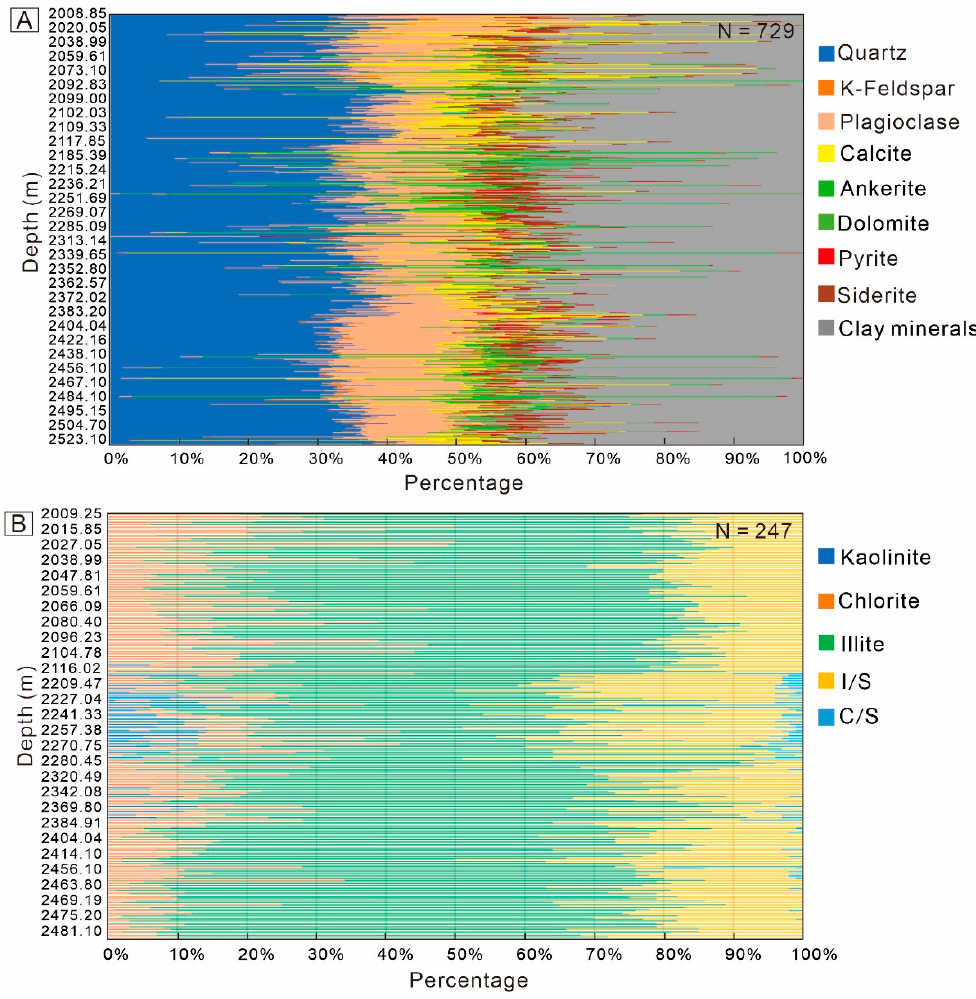
Figure 4. XRD data showing the mineral composition of the FGSRs of the Qingshankou Formation. ( A ) Whole ‐ rock mineral composition; ( B ) clay mineral composition. Note that I/S = mixed ‐ layer illite/smectite, C/S = mixed ‐ layer chlorite/smectite.